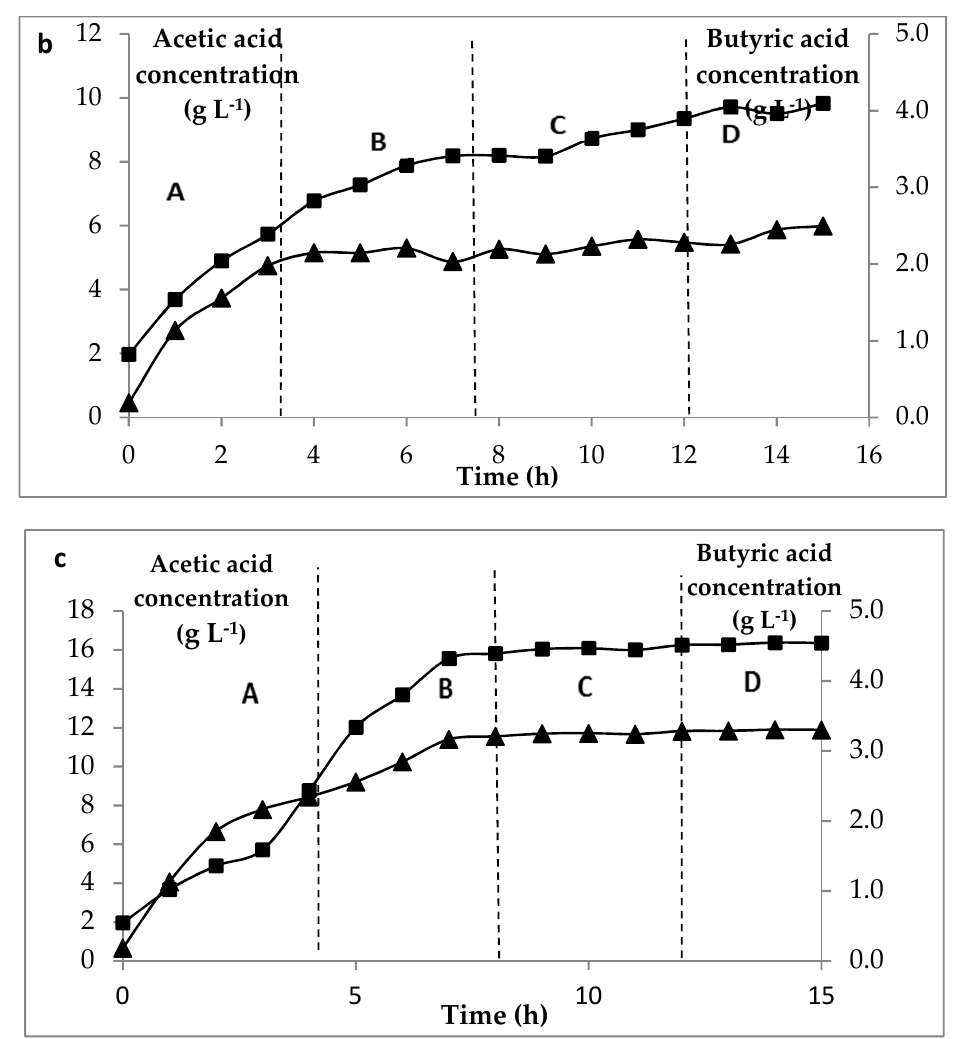
Figure 5. ( a – c ): The production of acetic ( (cid:4) ) and butyric acid ( (cid:78) ) by C. butyricum growth on glucose Figure 5. ( a – c ) The production of acetic ( ) and butyric acid ( ) by C. butyricum growth on glucose media at three concentrations of glucose. ( a ) for 5 g L − 1 feed, ( b ) 10 g L − 1 feed and ( c ) 15 g L − 1 , media at three concentrations of glucose. ( a ) for 5 g L −1 feed, ( b ) 10 g L −1 feed and ( c ) 15 g L −1 , at at permeation rates: A: 4 L h − 1 , B: 8 L h − 1 , C: 16 L h − 1 , D: 32 permeation rates: A: 4 L h −1 , B: 8 L h −1 , C: 16 L h −1 , D: 32 L h −1 .